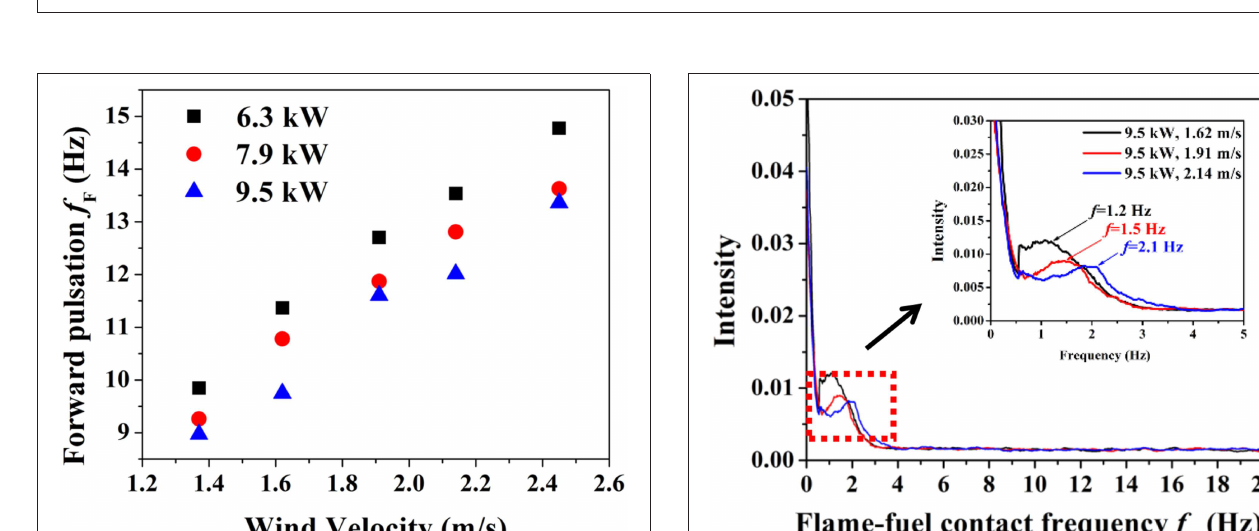
FIGURE 3 | Flame location between two time steps in a forced flow experiment and resultant flame locations with time. (A) Flame image in two consecutive time steps. (B) Flame extension distance downstream.